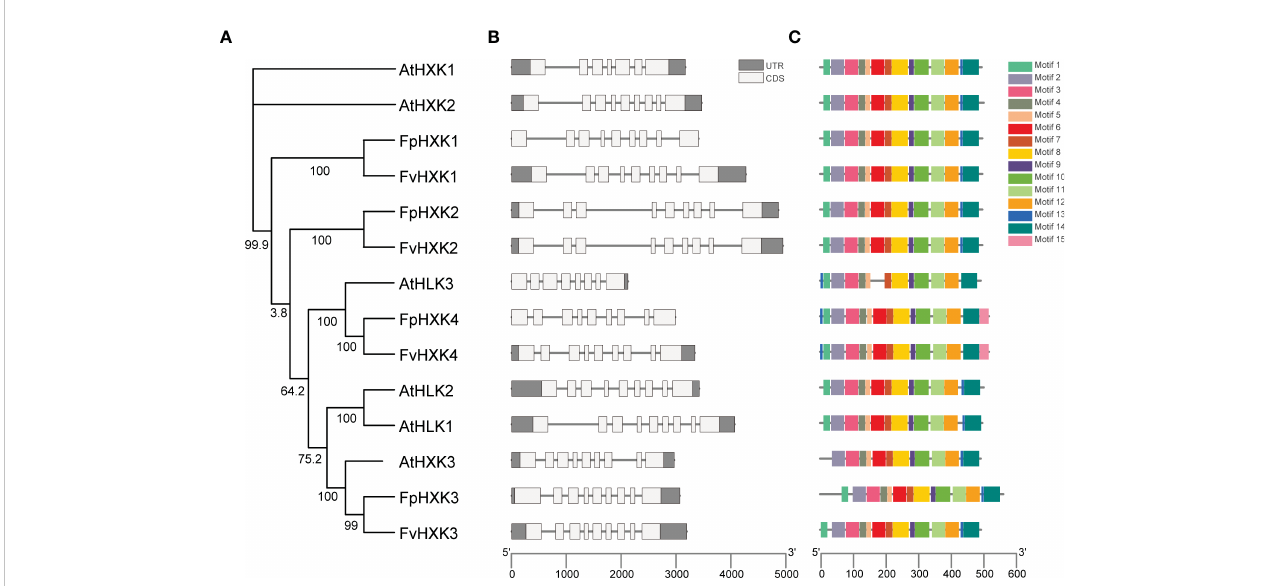
FIGURE 3 Protein motifs and gene structures of the HXKs in Arabidopsis and strawberry. (A) The phylogenetic dendrogram of the hexokinase genes in the Arabidopsis and strawberry genome. (B) The exon/intron structures of the HXK genes. The relative position and size of the exon (white box) and UTR (gray box) can be estimated using the scale bar at the bottom. (C) The putative conserved motifs in HXKs. Different motifs and their relative positions are represented by the colored boxes at the top